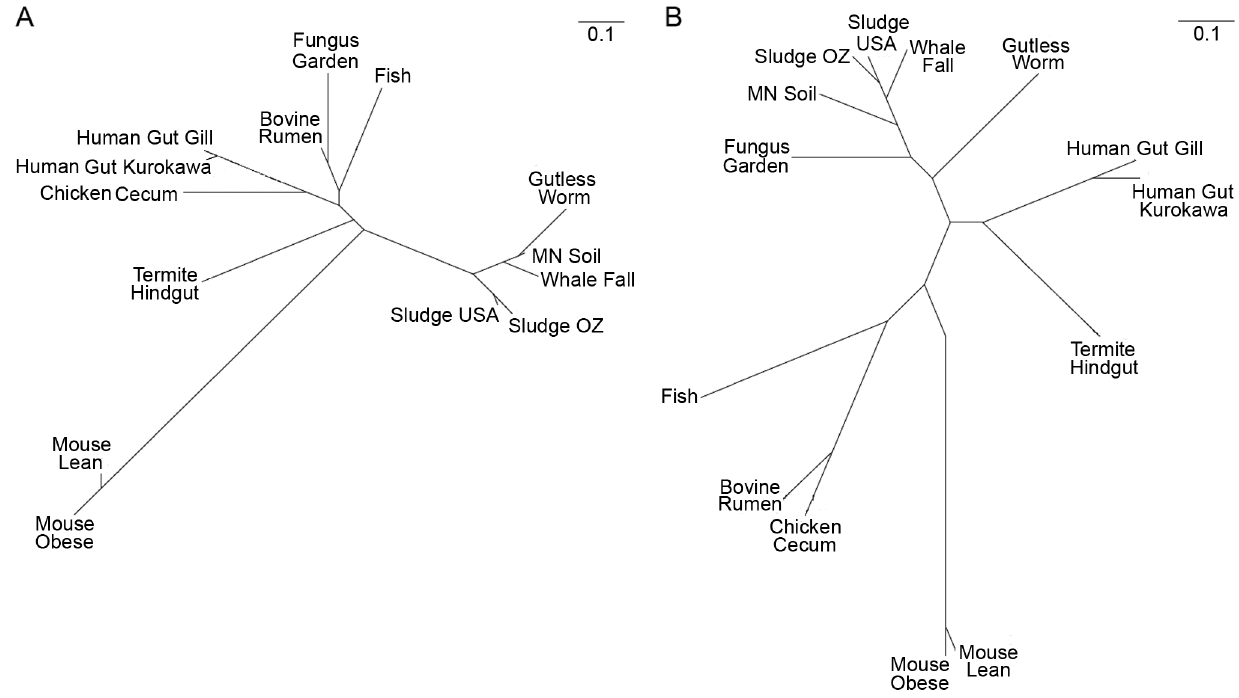
Figure 3. CAZy clustering of the fungus garden metagenome. Comparative clustering of the leaf-cutter ant fungus garden community metagenome with 13 other metagenomes. The predicted proteome from each metagenome was compared using carbohydrate-active enzymes (CAZy) profiles (A) and clusters of orthologous groups (COGs) profiles (B). CAZy and COG profiles for each metagenome was generated and clustered using Pearson’s product moment. An unrooted tree (UPGMA) was then generated using PHYLIP and visualized using phylodendron.